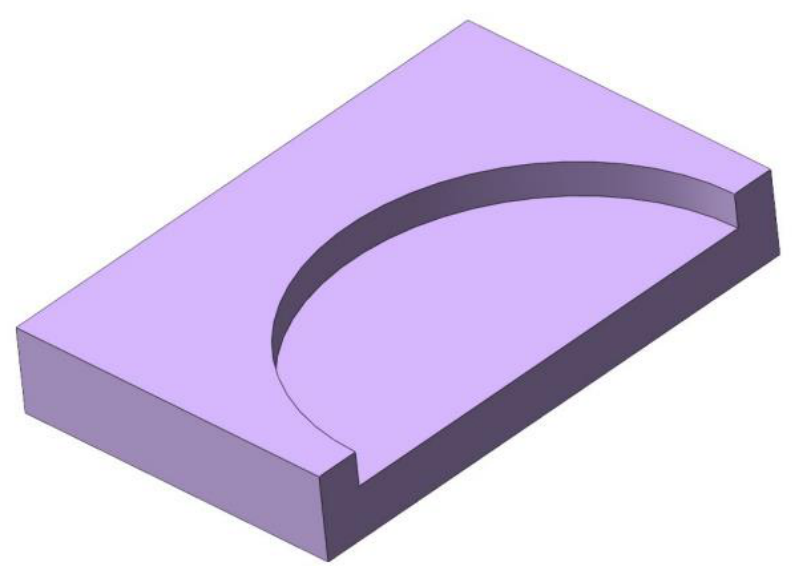
Figure 3. Geometric model of workpiece.